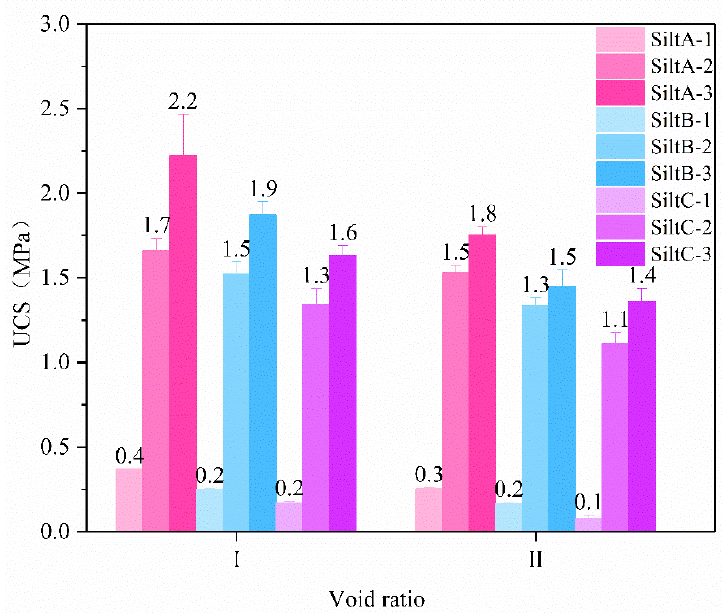
Figure 11. Influence of different pore ratios on unconfined compressive strength.